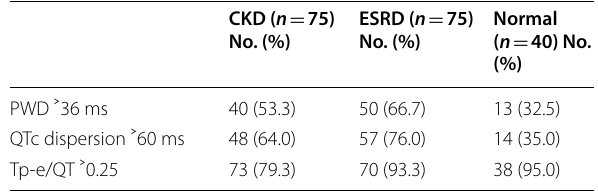
Table 5 The frequency of abnormal ECG changes in the study